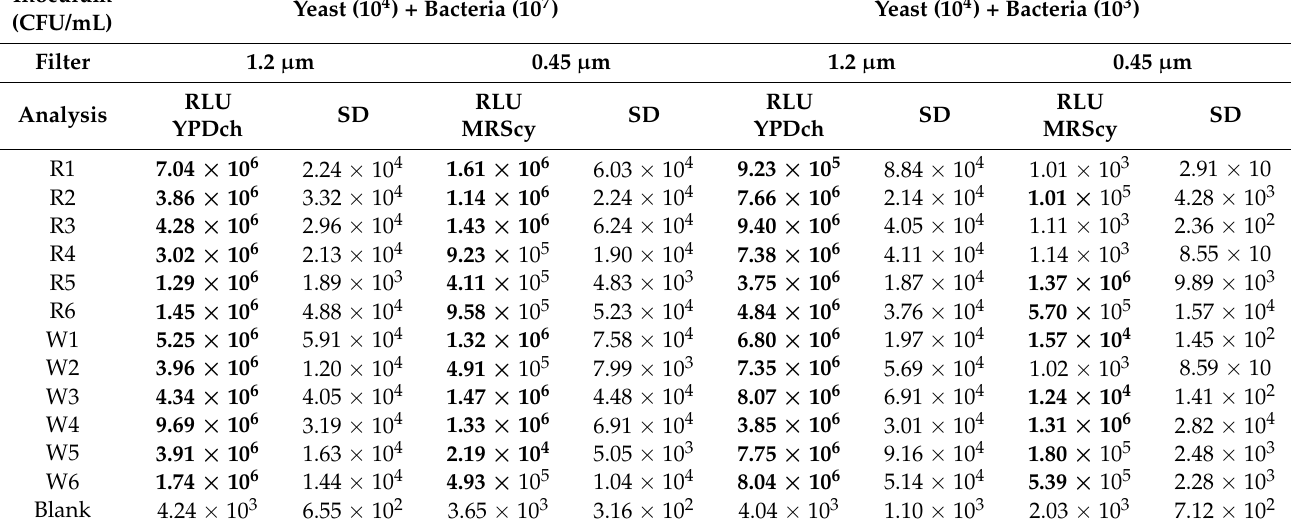
Table 3. Bioluminescence assay (RLU). Sample RLU values 3 times higher than the blank RLU value indicate contamination (by yeasts when YPDch is used as resuscitation medium for 1.2 µ m filters, bacteria when MRScy is used to resuscitate cells on 0.45 µ m filters) and are indicated in bold. If the RLU value is between 2 and 3 times the blank, the result of the analysis is defined as uncertain. The medium is considered sterile if the RLU value is lower than 2 times the RLU of the blank (selective YDPch for yeasts, MRScy for bacteria). “W” stands for white wine, “R” for the red wine. All analyses were performed in triplicate, and the results are the mean of the 3 replicates ± standard deviation